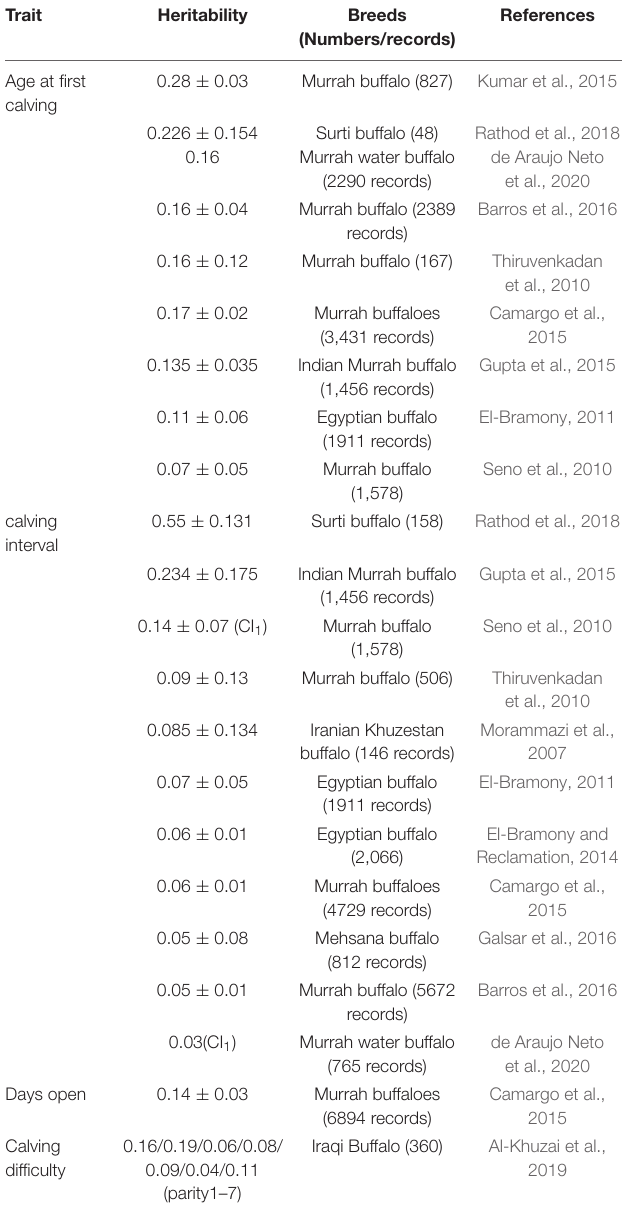
TABLE 4 | Heritability estimates of reproduction traits in